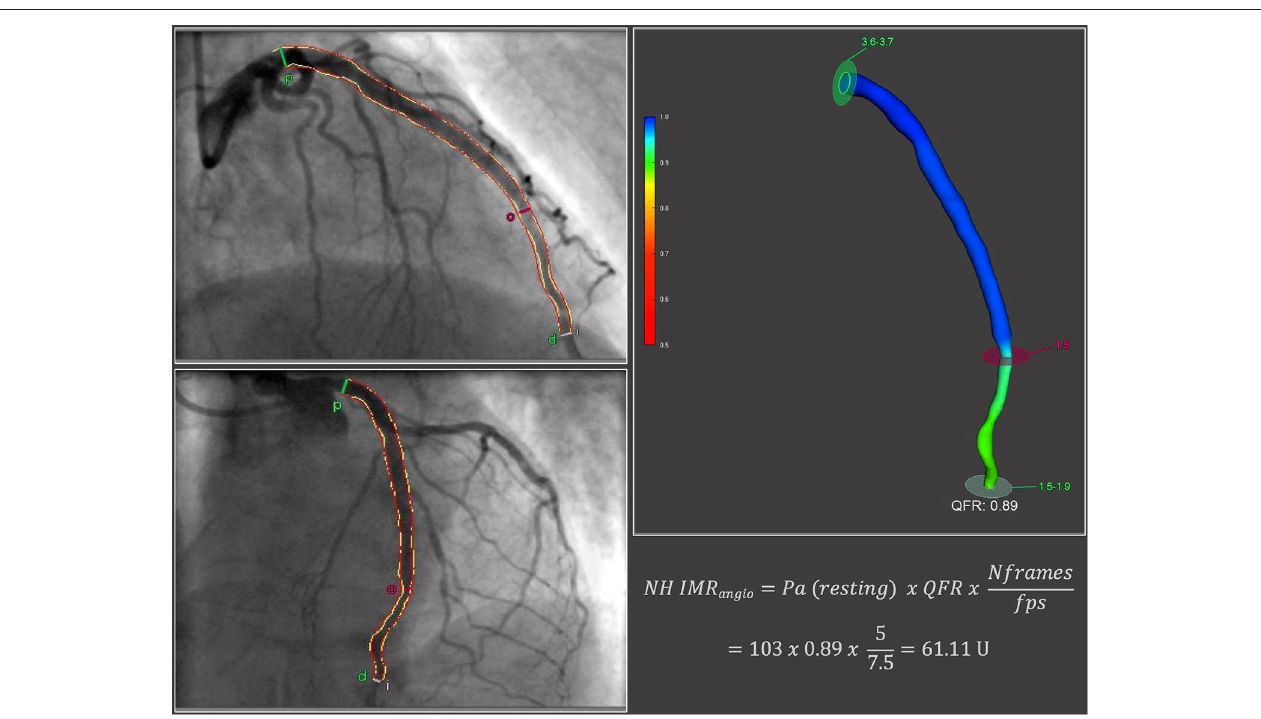
FIGURE 1 | NH IMR angio derivation. fps, frames per second; Nframes, number of angiographic frames from contrast dye to travel from the guiding catheter to a distal reference in resting conditions; NH IMR angio , non-hyperaemic IMR angio ; Pa, post percutaneous coronary intervention mean aortic pressure at resting conditions; QFR, quantitative flow